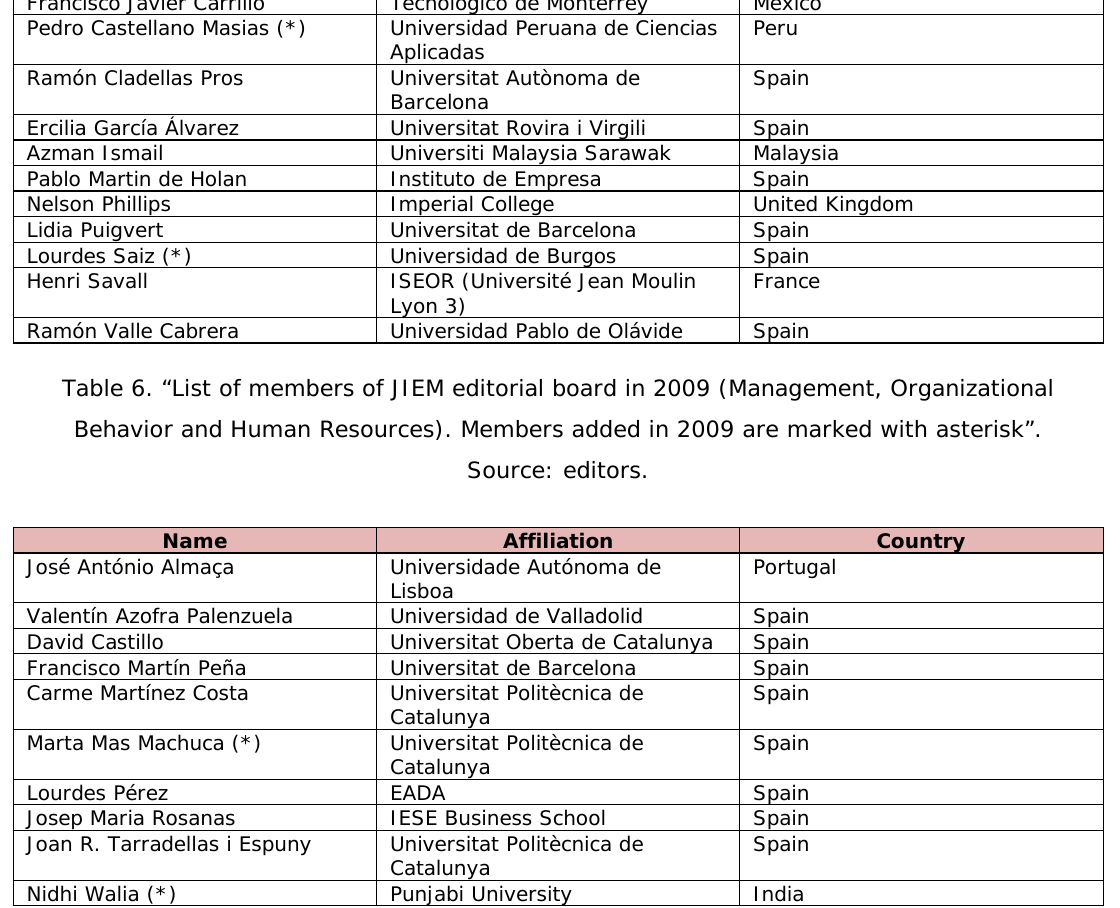
Table 7. “List of members of JIEM editorial board in 2009 (Finance, Accounting and Marketing in Industrial Sectors). Members added in 2009 are marked with asterisk”. Source: